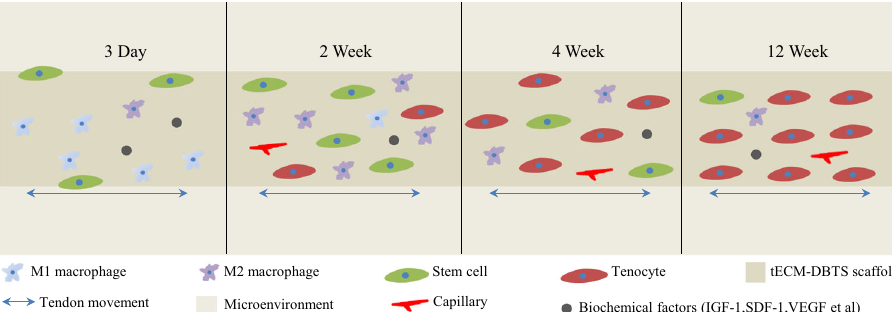
Fig. 9 Schematic illustration of the tendon regeneration process of the tECM-DBTS scaffold in vivo. Changes in tendon at different time points were described.